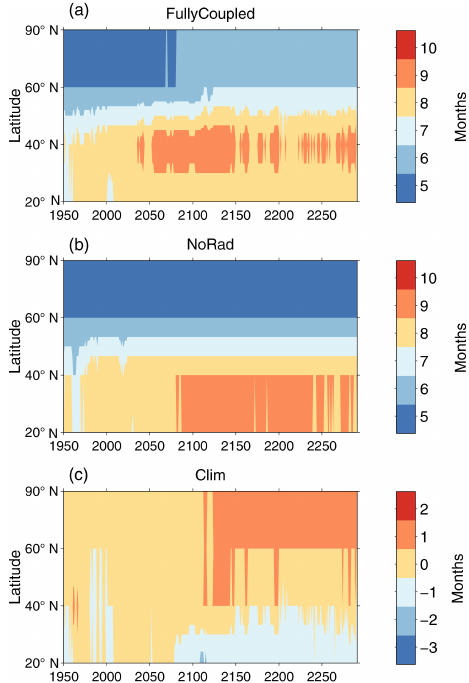
Figure 14. Growing season length (10-year running median of months with NEP < 0) in each latitude band in the (a) FullyCou- pled and (b) NoRad simulations. (c) The contribution of climate change to growing season